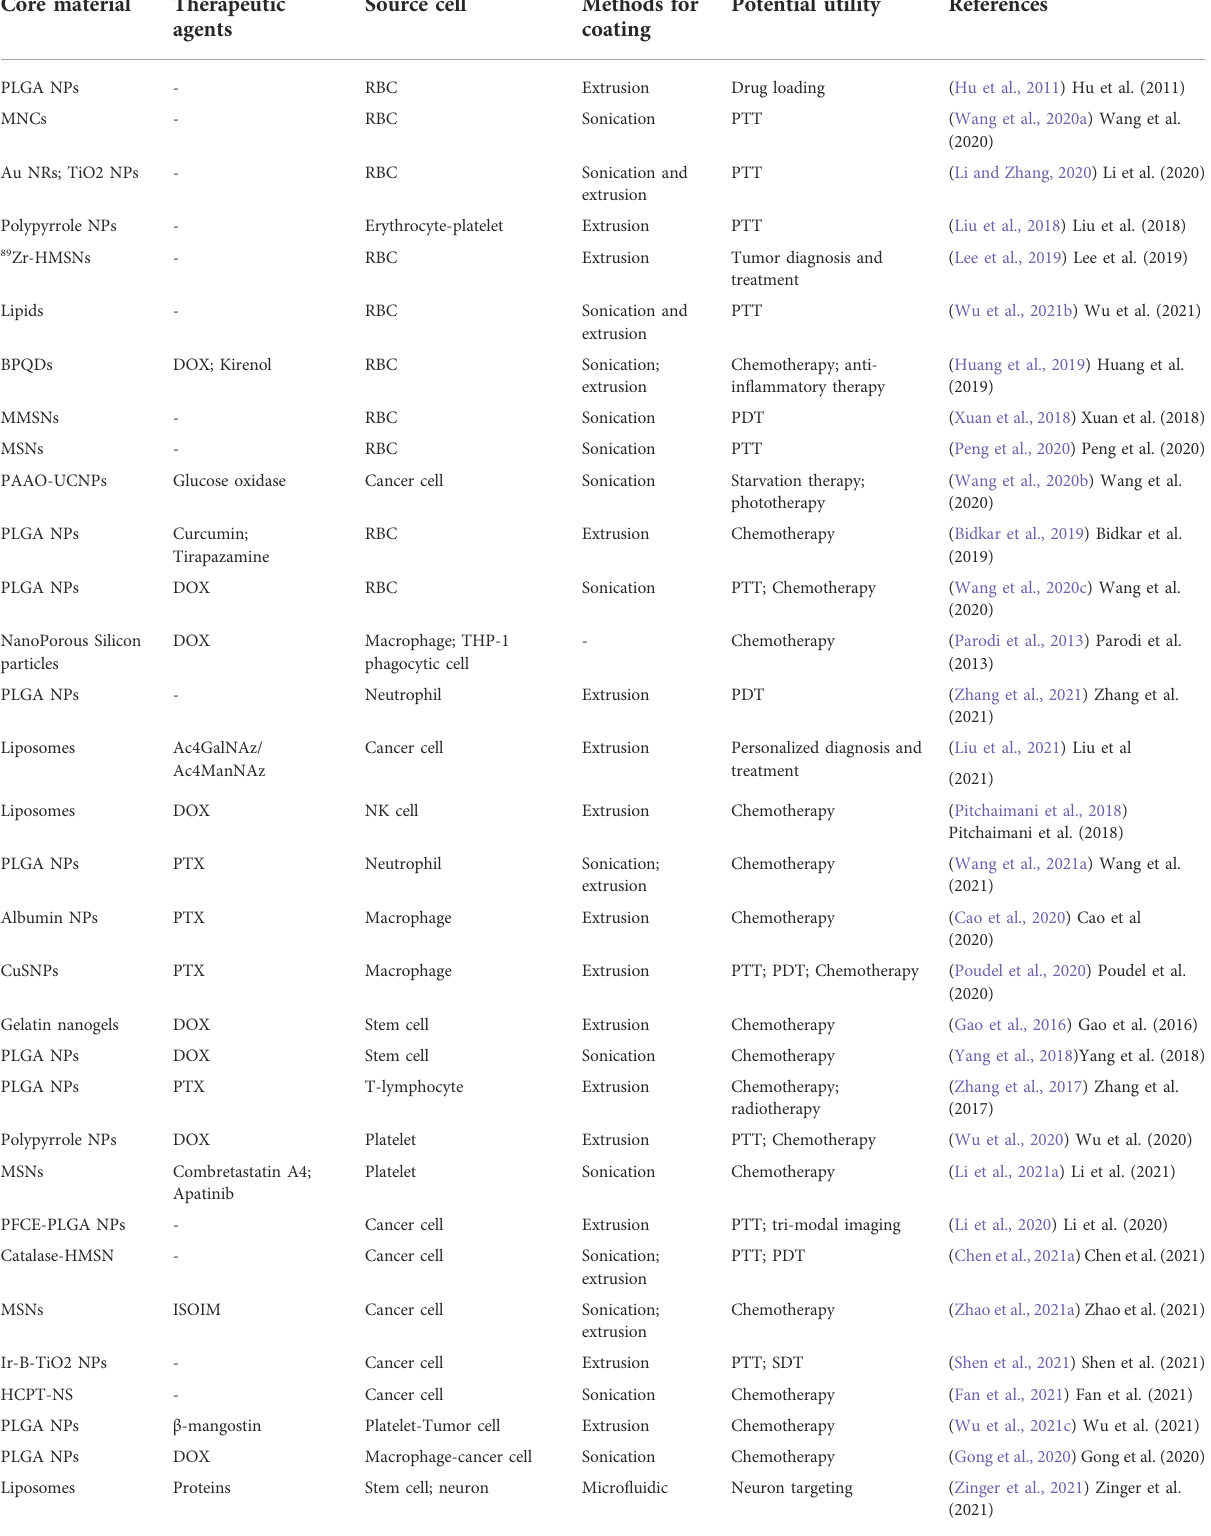
TABLE 2 Different synthetic cores and source cells for membrane camou fl aged nanoparticles and potential